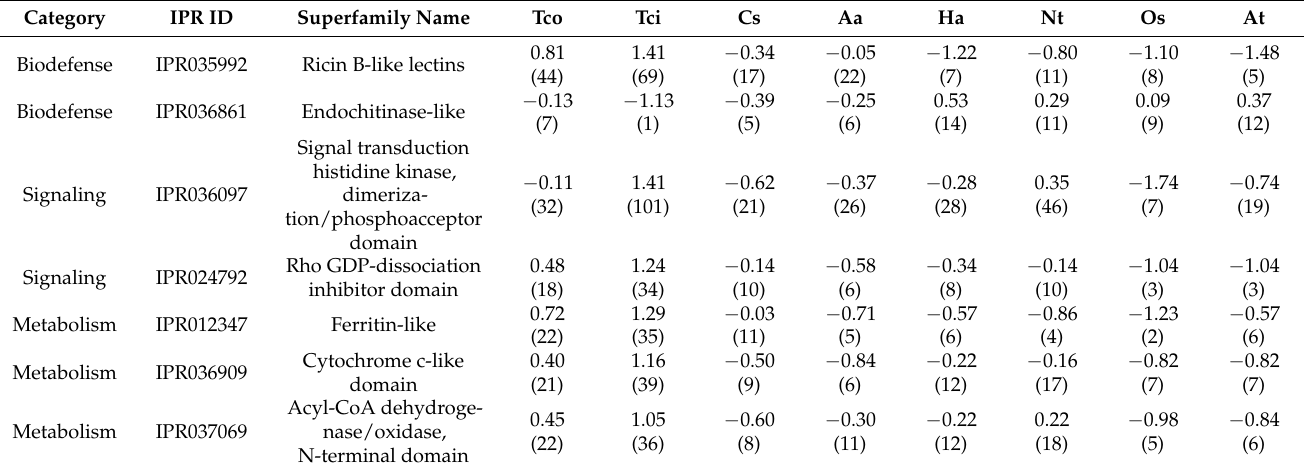
Parenthesized numbers indicate the number of genes categorized in each superfamily. Tco: T. coccineum ; Tci: T. cinerariifolium ; Cs: C. seticuspe ; Aa: A. annua ; Ha: H. annuus ; Nt: N. tabacum ; Os: O. sativa ; At: A. thaliana